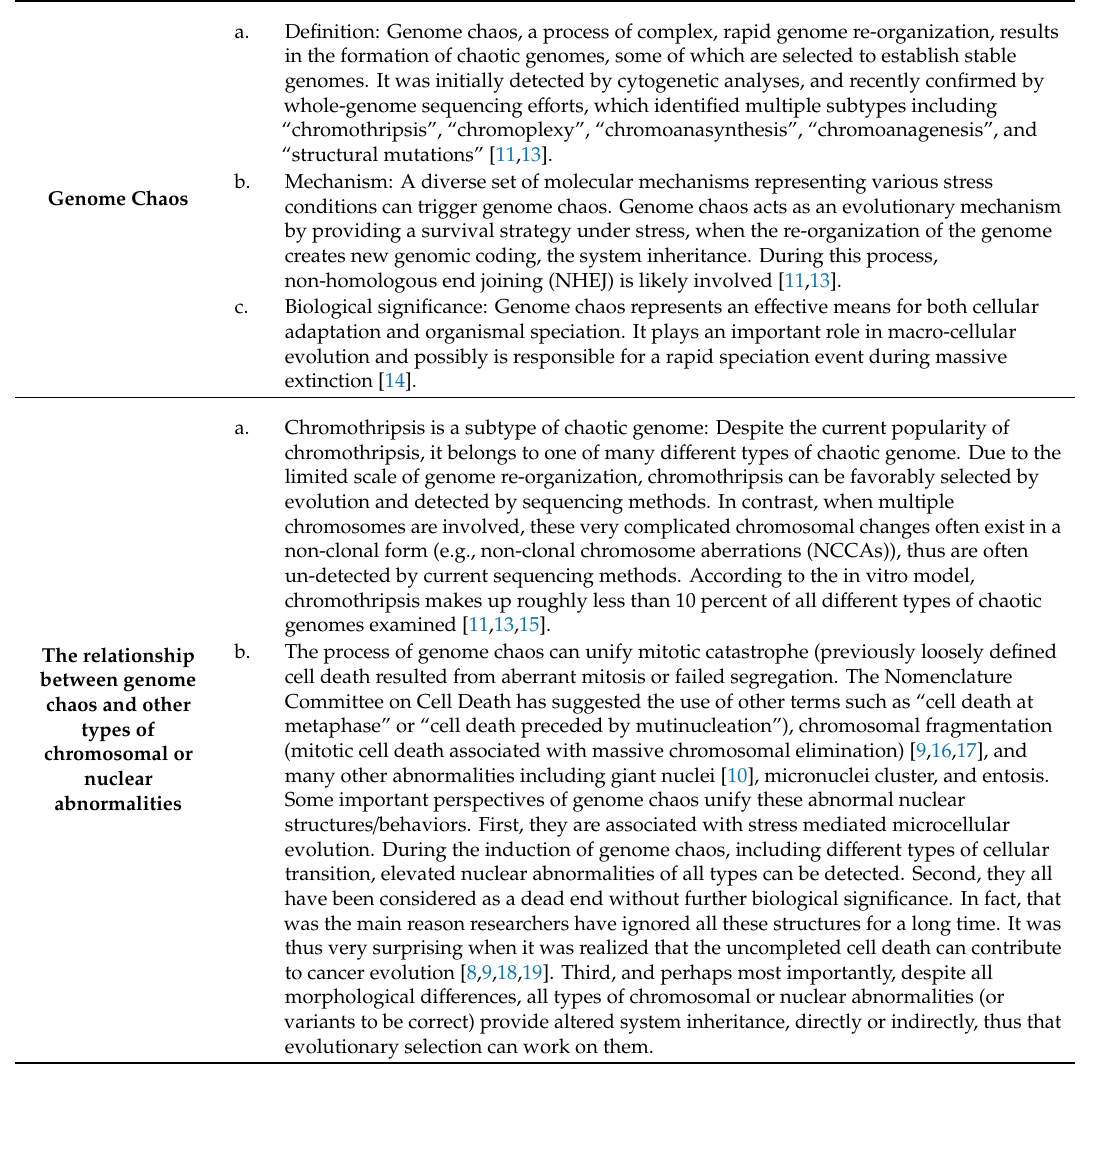
Table 1. Explanations of key concepts /